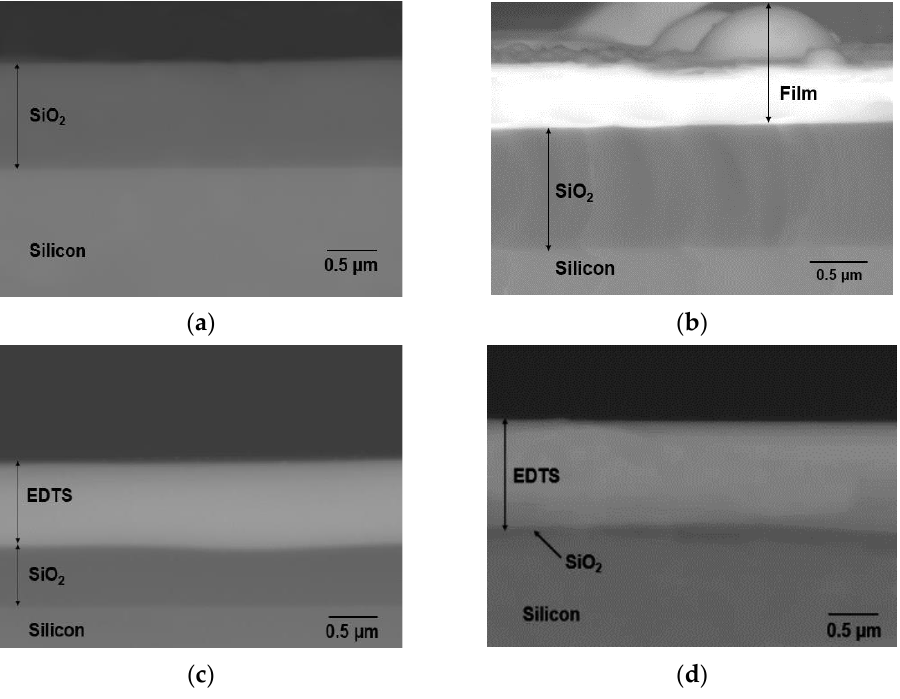
Figure 1. Backscattered cross-sectional SEM image of ( a ) bare SOS substrate and samples doped with Er-TZN when the substrate was heated at ( b ) 400 °C (B400), ( c ) 570 °C (B570), and ( d ) 700 °C (B700).